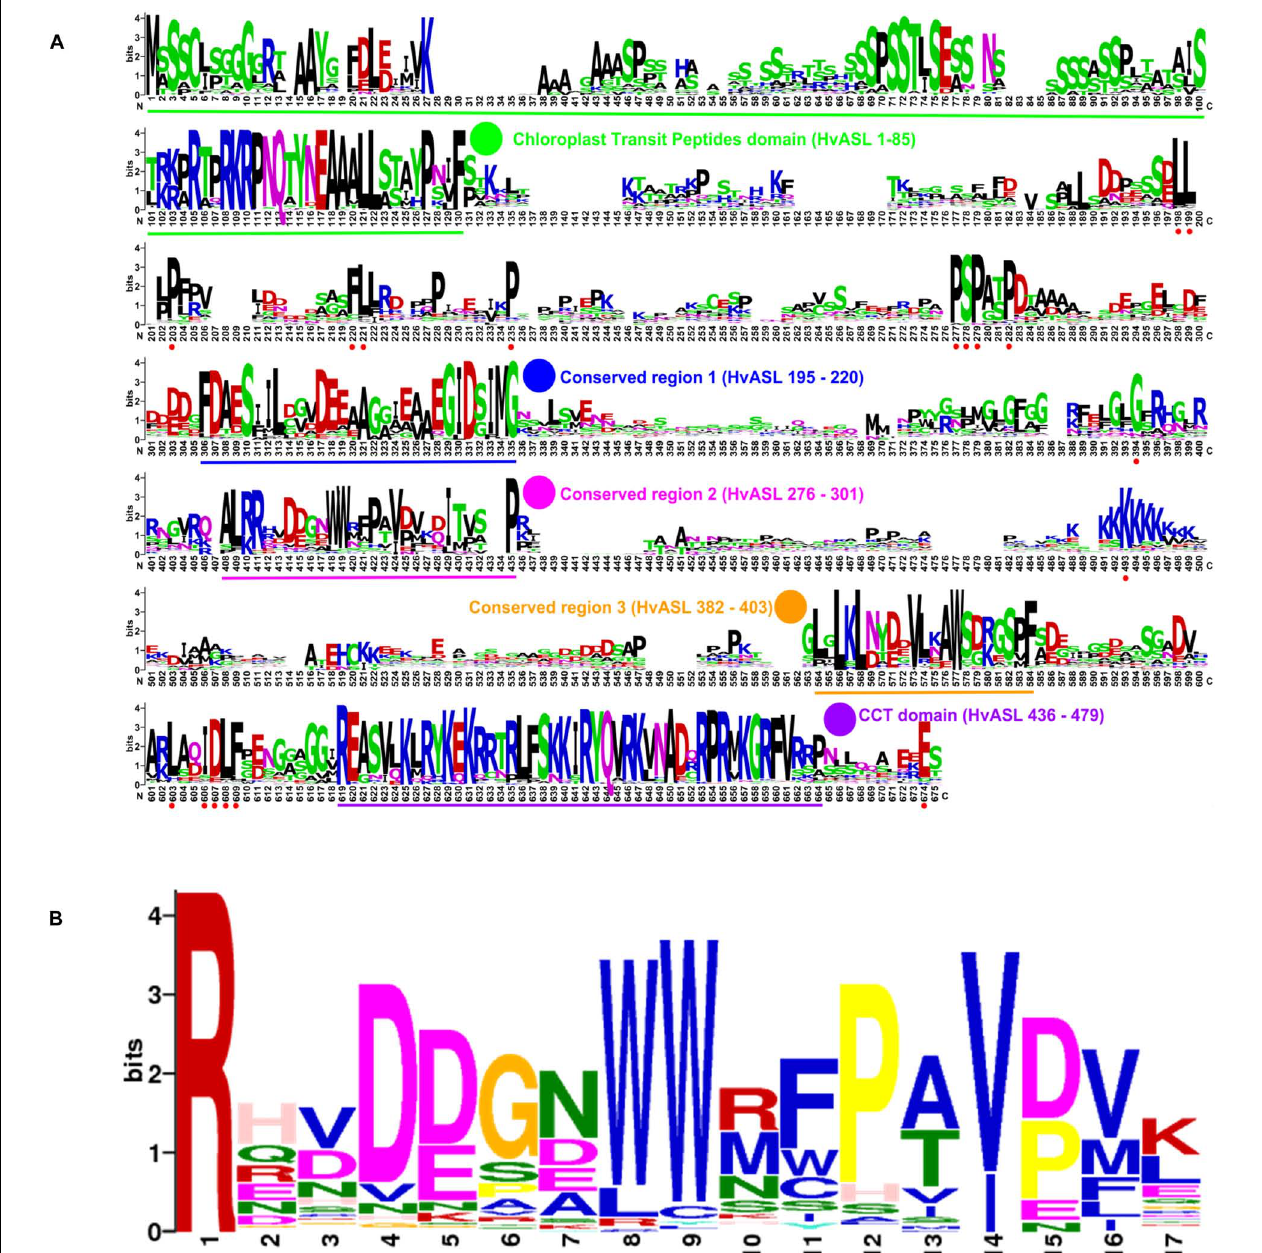
FIGURE 4 | Novel conserved functional region of HvCMF3. (A) Alignment of 131 HvCMF3 homologous protein sequences from 66 species revealed five conserved regions which include the N-terminal chloroplast transit peptides domain, the C-terminal CCT domain and three novel conserved regions. In addition, the homologous genes contain multiple conserved peptides indicated by red dots below the position IDs. The conserved regions are marked with underline and highlighted with colored circles. The region given in parentheses indicates the corresponding position of the conserved region in reference to HvCMF3. Alignment was manually edited by removing wrongly predicted sequence regions and by filling gaps. There were a total of 675 positions left. The online tool Weblogo was adopted for graphic generation. (B) Conservation analysis of the functional region of HvCMF3 identified in this study. For each position, the overall height of the stack indicates the sequence conservation at that position, while the height of symbols within the stack indicates the relative frequency of each amino acid at that position.